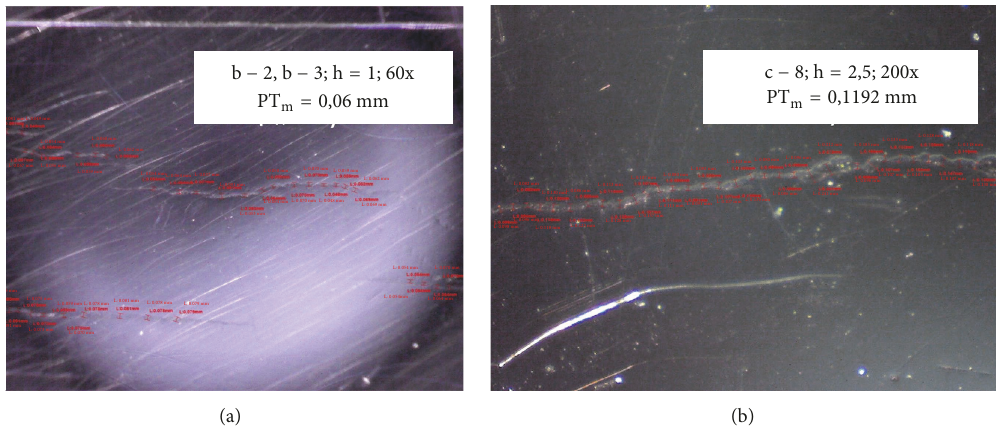
Figure 7: Microscopic examination of cracked